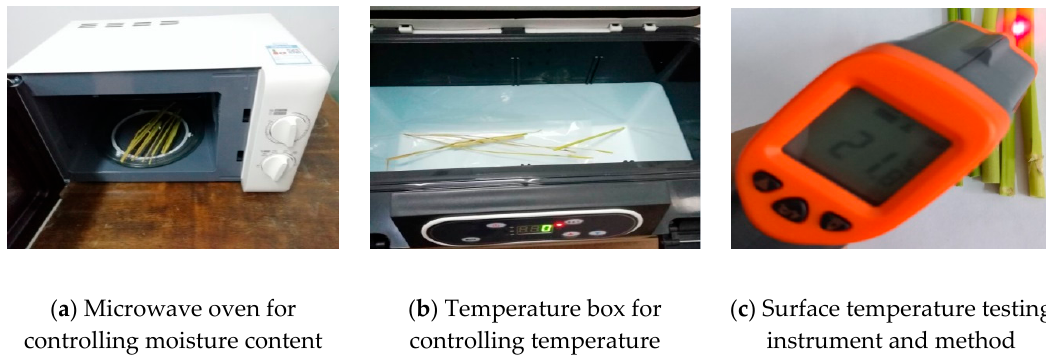
Figure 6. Moisture content and temperature control equipment and methods.